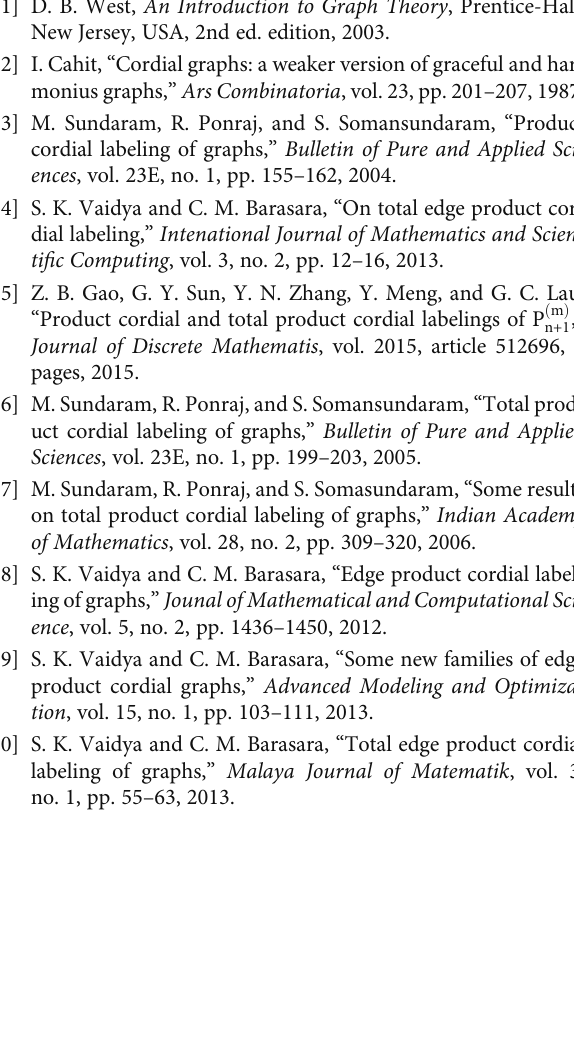
Figure 6: The generalize dragon fl y graph Dg ð 3,3 Þ